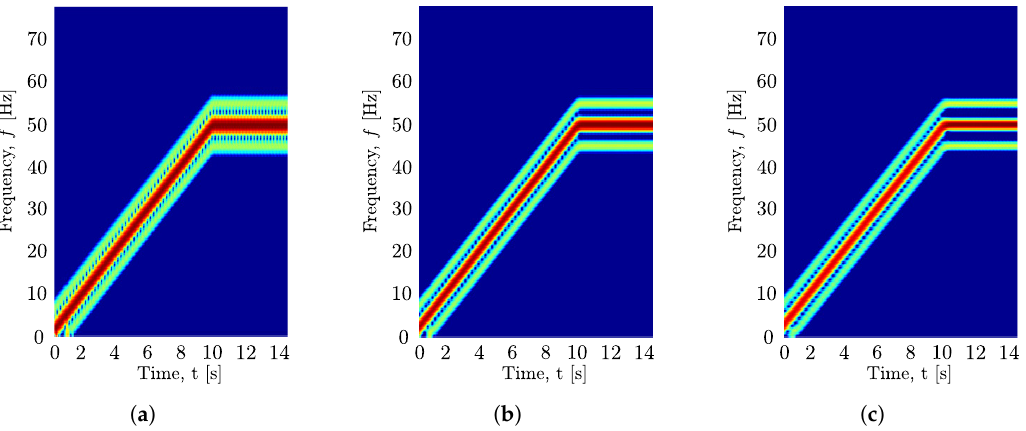
Figure 3. Synthetic signal spectra using fractional Gaussian windows based on Caputo–Dzhrbashyan (CD) operator and varying n sc , with µ = 5 and σ = 0.3. ( a ) n sc = 100; ( b ) n sc = 150; ( c ) n sc =